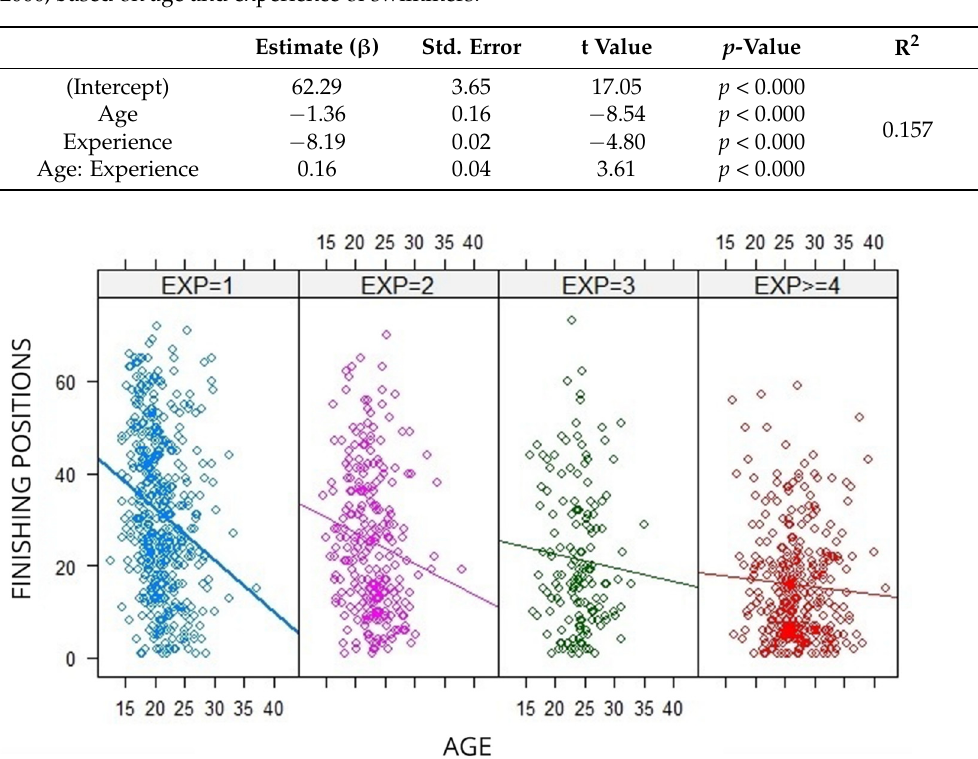
Figure 2. Regression analyses for finishing positions in the 10-km races of the WCH and OG since 2000, based on age and experience of swimmers. The four modules from left to right represent swimmers with one, two, three, and four or more years of experience.